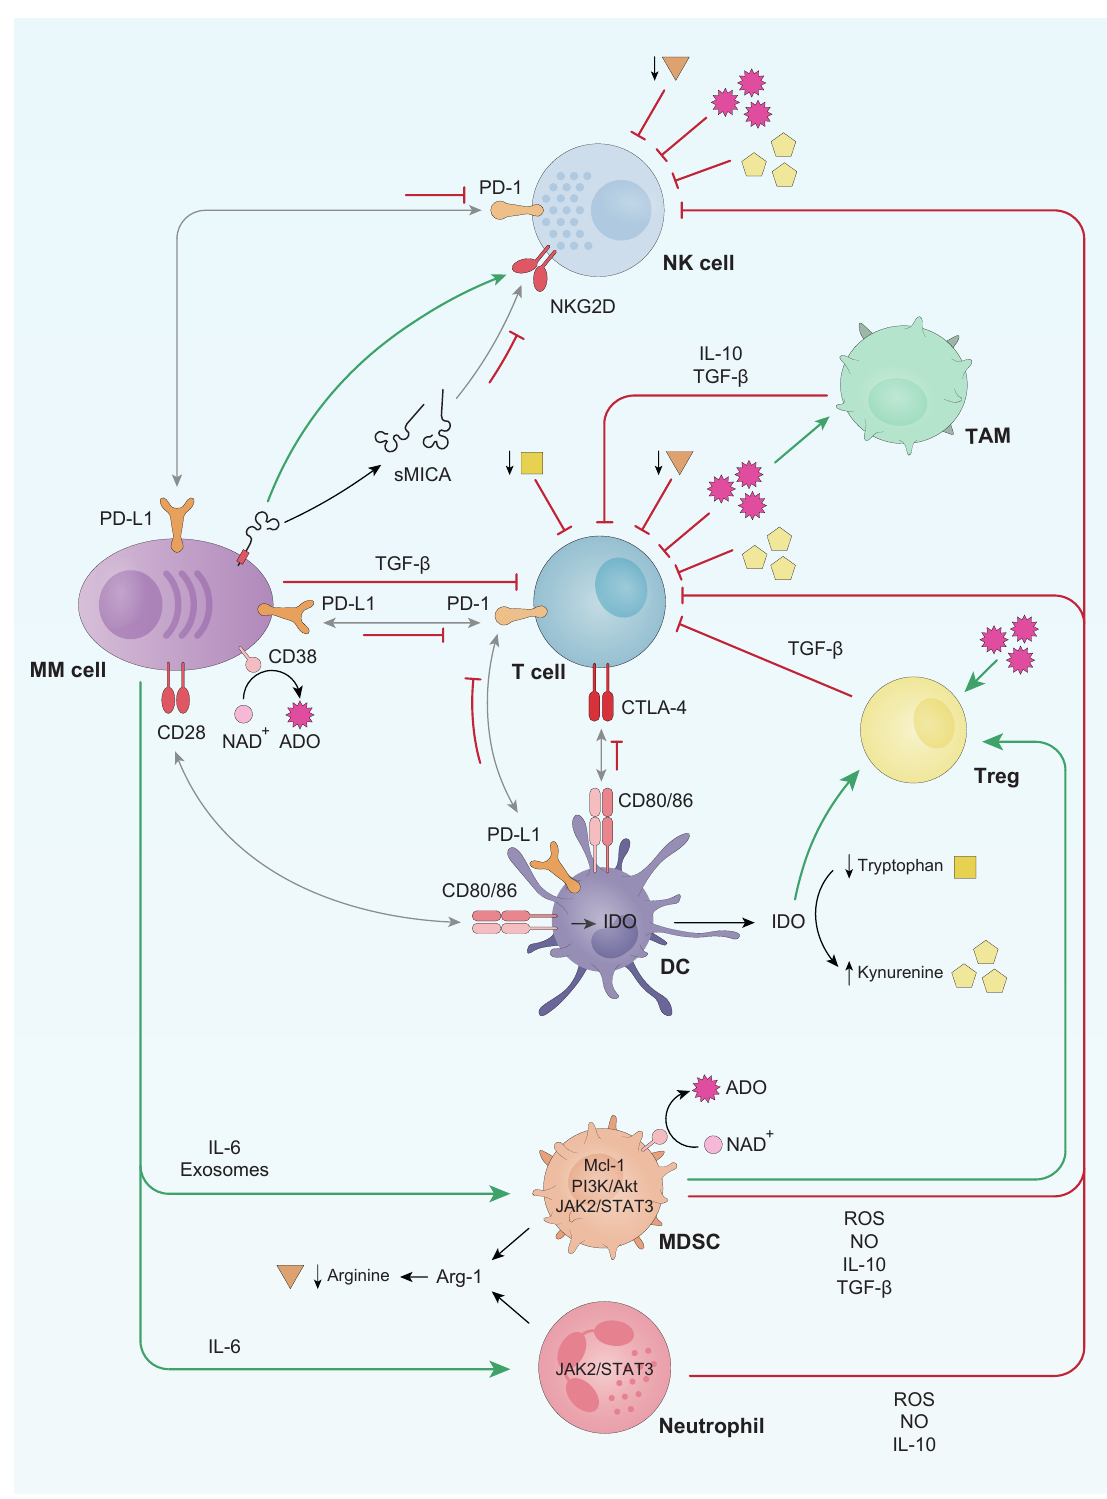
Figure 1. Schematic representation of the main immune system alterations described in multiple myeloma (MM) patients. Briefly, T and natural killer (NK) cells are inhibited through both soluble factors and cell-to-cell contacts with either myeloma cells or other immune cell populations. Grey arrows refer to receptor-ligand union, green arrows stand for activation whereas red bar-headed lines indicate inhibition. Regarding soluble factors, squares refer to tryptophan, pentagons to kynurenine, spiked circles to adenosine (ADO) and triangles to arginine. TAM: tumor associated macrophages; Treg: regulatory T lymphocytes; MDSC: myeloid derived suppressor cells; IDO: